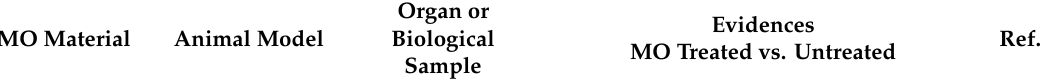
Table 4. E ff ects of M. oleifera on lipids, histopathology and gene expression in diabetic animal models.